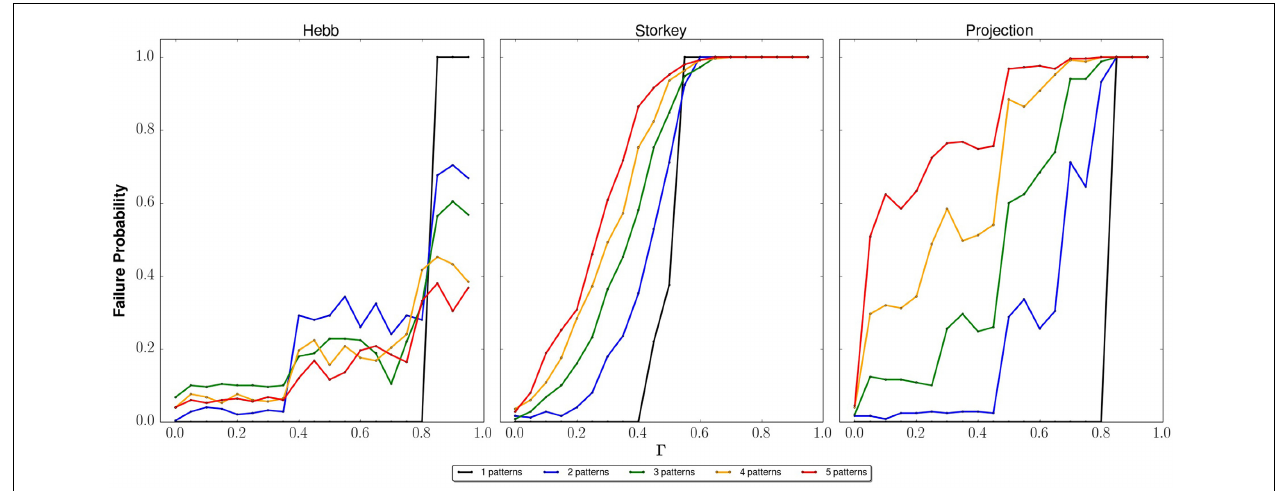
FIGURE 9 | Average probability to recall a memory not stored in the network with respect to applied bias, i.e., failure. The average is taken over an ensemble of network instances with n = 5 neurons and p = 1 , 2 , 3 , 4, or 5 stored memories. Each panel plots the failure